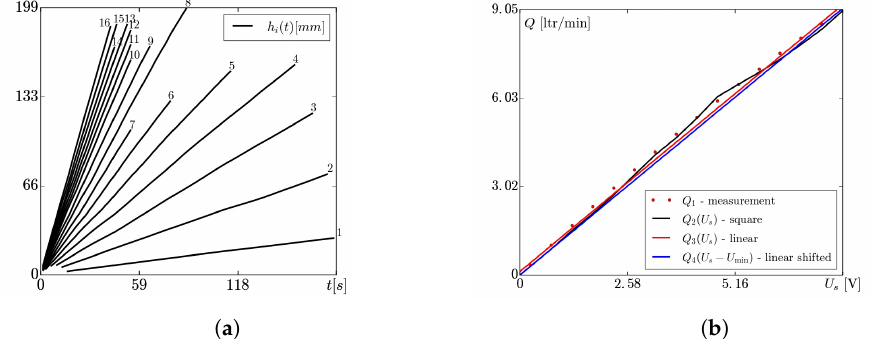
Figure 7. Identification of pump performance. ( a ) Static characteristics h i ( t ) . ( b ) Square and linear approximation of efficiency.